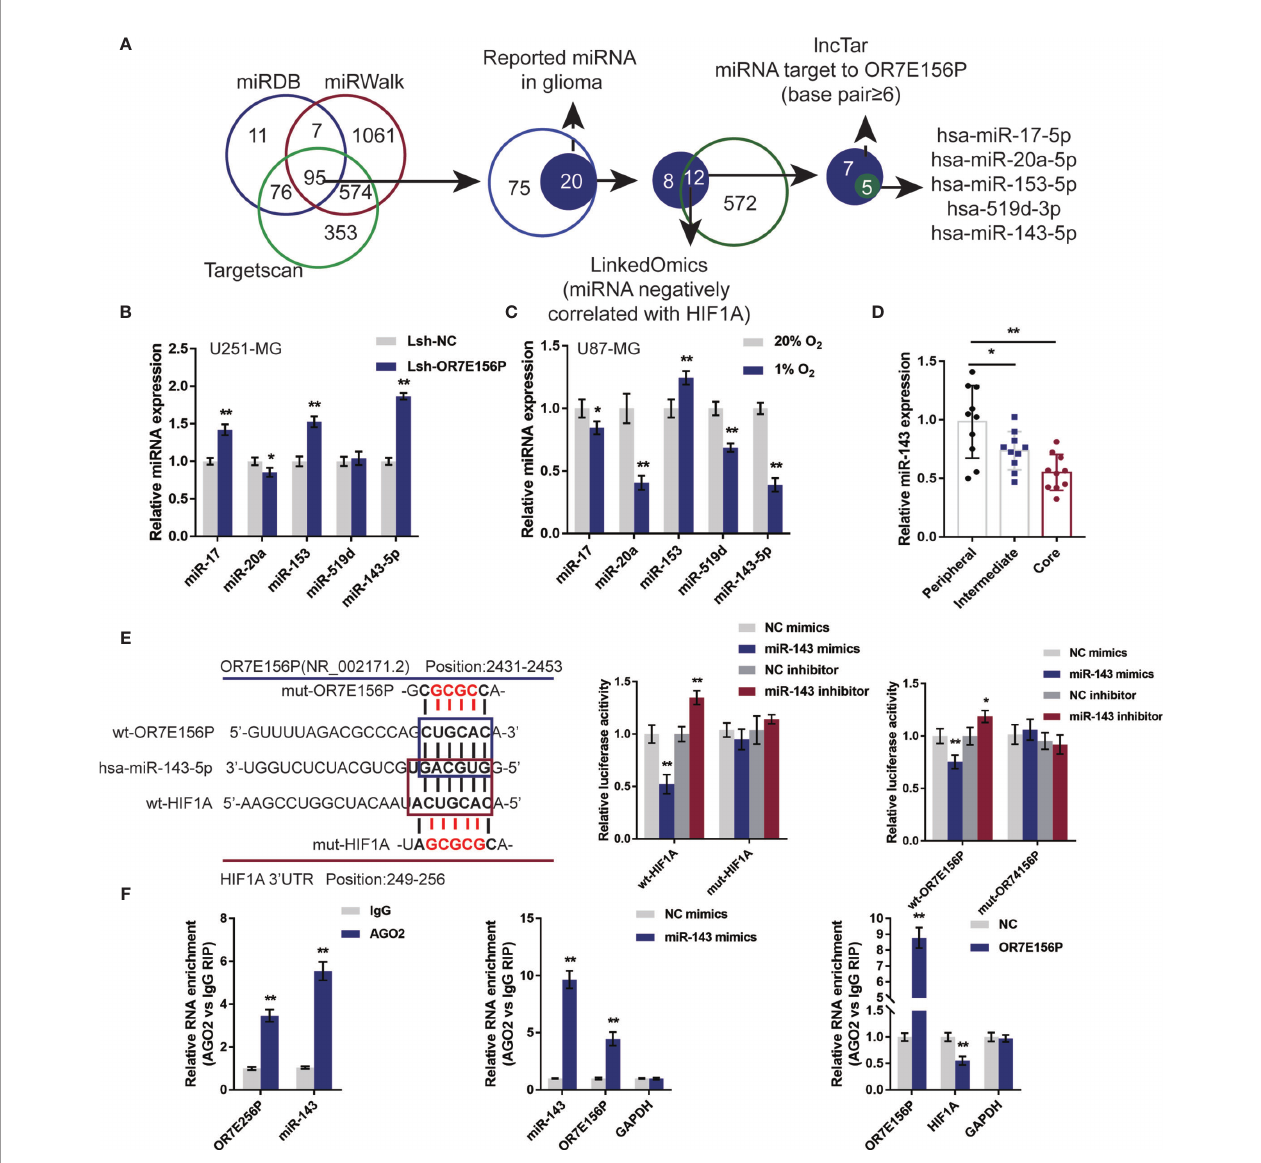
FIGURE 5 | miR-143 is involved in the cross-talk between OR7E156P and HIF1A (A) A schematic diagram showing the selection of miRNAs related to glioma and might simultaneously target OR7E156P and HIF1A. Five miRNAs were selected: miR-17, miR-20a, miR-153, miR-519d, and miR-143-5p. (B) U251-MG and U87- MG cells were infected with Lsh-OR7E156P and examined for the expression of miR-17, miR-20a, miR-153, miR-519d, and miR-143-5p by real-time PCR. (C) U251-MG and U87-MG cells were exposed to 1% or 20% oxygen and examined for the expression of miR-17, miR-20a, miR-153, miR-519d, and miR-143-5p by real-time PCR. (E) Wild-type and mutant-type OR7E156P or HIF1A 3 ’ UTR luciferase reporter vectors were constructed as described in the Materials and Methods section. These vectors were co-transfected in 293T cells with miR-143 mimics or miR-143 inhibitor. The luciferase activity was determined. (F) RIP assays were performed to con fi rm the binding of miR-143 to OR7E156P and the 3 ’ -UTR of HIF1A using AGO2 antibody. The levels of miR-143, OR7E156P, and HIF1A in precipitated AGO2 proteins were examined using real-time PCR. * P < 0.05, ** P <